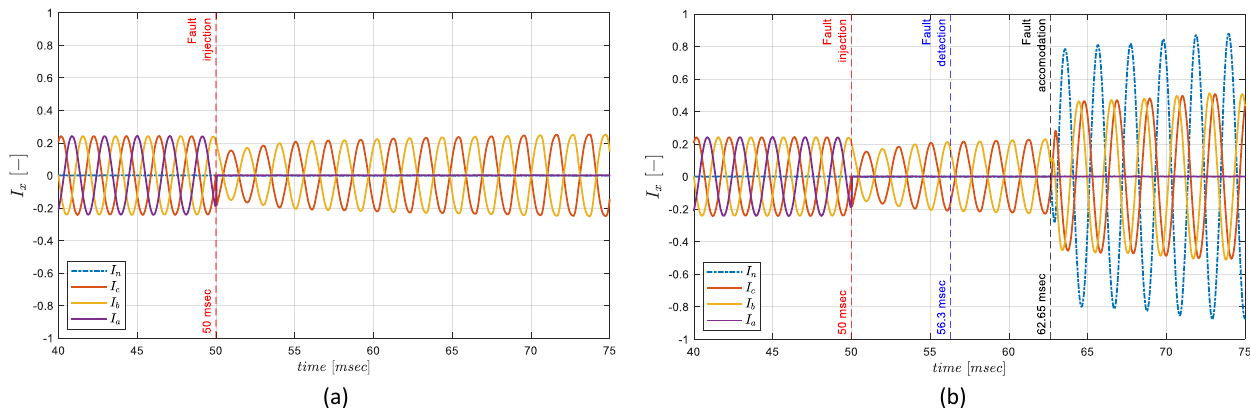
Figure 15. Normalized phase currents with open circuit on phase a at t = 50 msec ( I lim = 92 A): ( a ) without FTC, ( b ) with FTC.